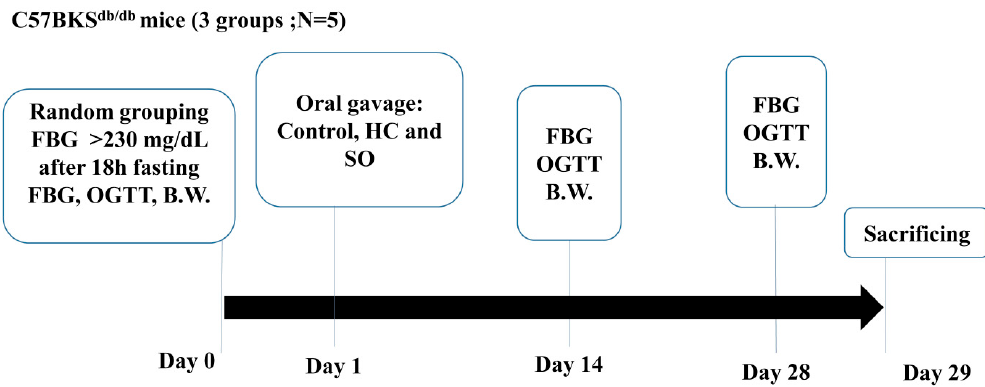
Figure 1. Study procedure for the C57BKS db/db mice (termed db/db here). Fifteen male db/db mice were randomly divided into three groups ( N = 5): Control, treatment with Hedychium coronarium leaves (HC), or SugarOut (SO) supplement. FBG, fasting blood glucose; OGTT, oral glucose tolerance test; B.W., Body Weight.